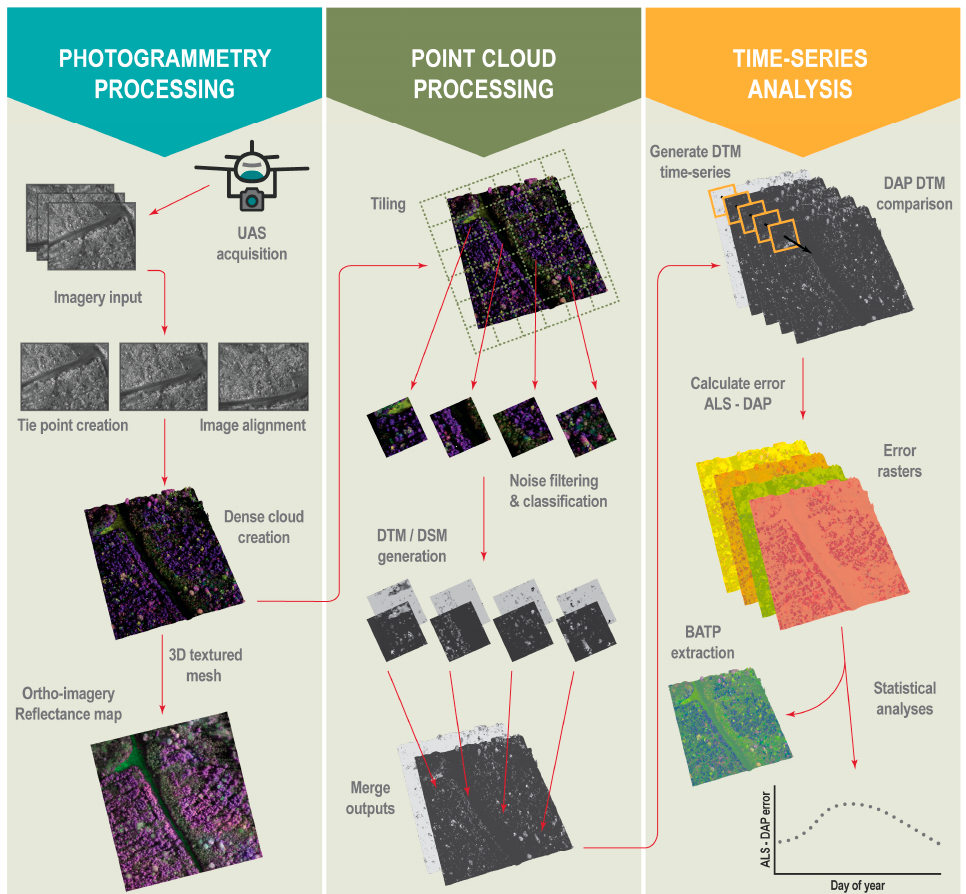
Figure 1. Methodological flow chart of photogrammetric processing, point cloud post processing, and time series digital terrain models (DTM) analysis. UAS—unmanned aerial systems; DAP—digital aerial photogrammetry; DSM—digital surface model; BATP—best available terrain pixel; ALS—airborne laser scanning. Remote Sens. 2018 , 10 , x FOR PEER REVIEW 5 of 16